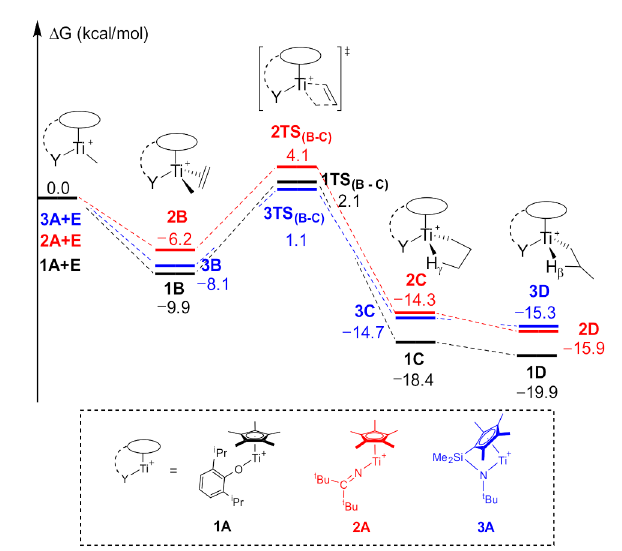
Figure 3. The calculated free energy profiles (energy in kcal/mol) for initiation stage of ethylene polymerization catalyzed by half-titanocenes.